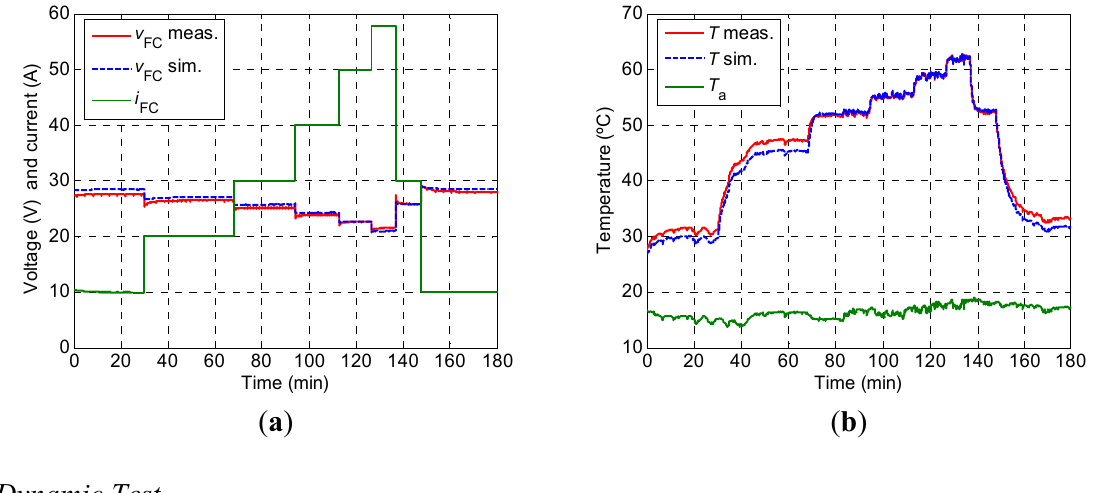
Figure 12. Experimental validation of the FC models, drawing a stepped current, with a current variation of 10 to 58 A. ( a ) current demand ( i sim.); ( b ) temperature measured ( T meas.) and simulated ( T sim.) and and simulated ( v FC ambient temperature ( T a